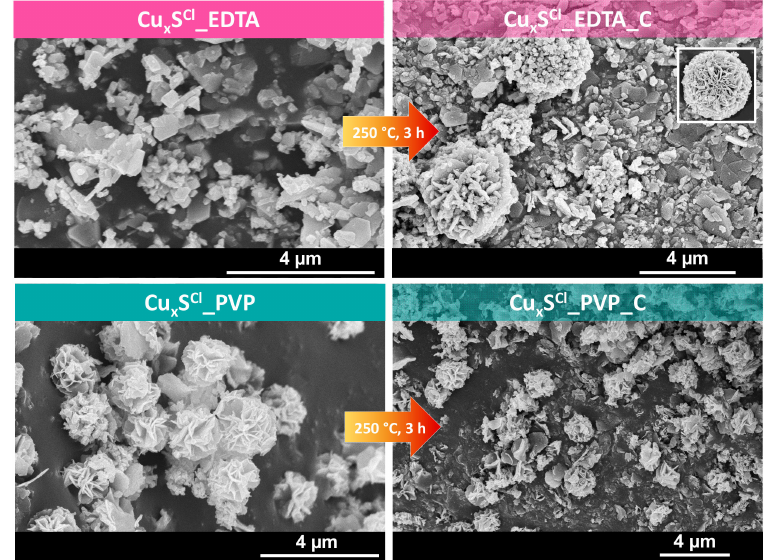
Figure 3. SEM micrographs of Cu x S samples prepared using CuCl 2 · 2H 2 O as the precursor and di ff erent stabilizing agents (EDTA or PVP). The heat-treated samples (250 ◦ C, 3h) are also